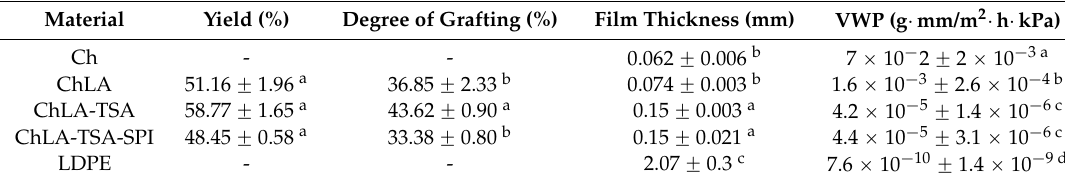
Table 1. Experimental data for chitosan and chitosan-grafted